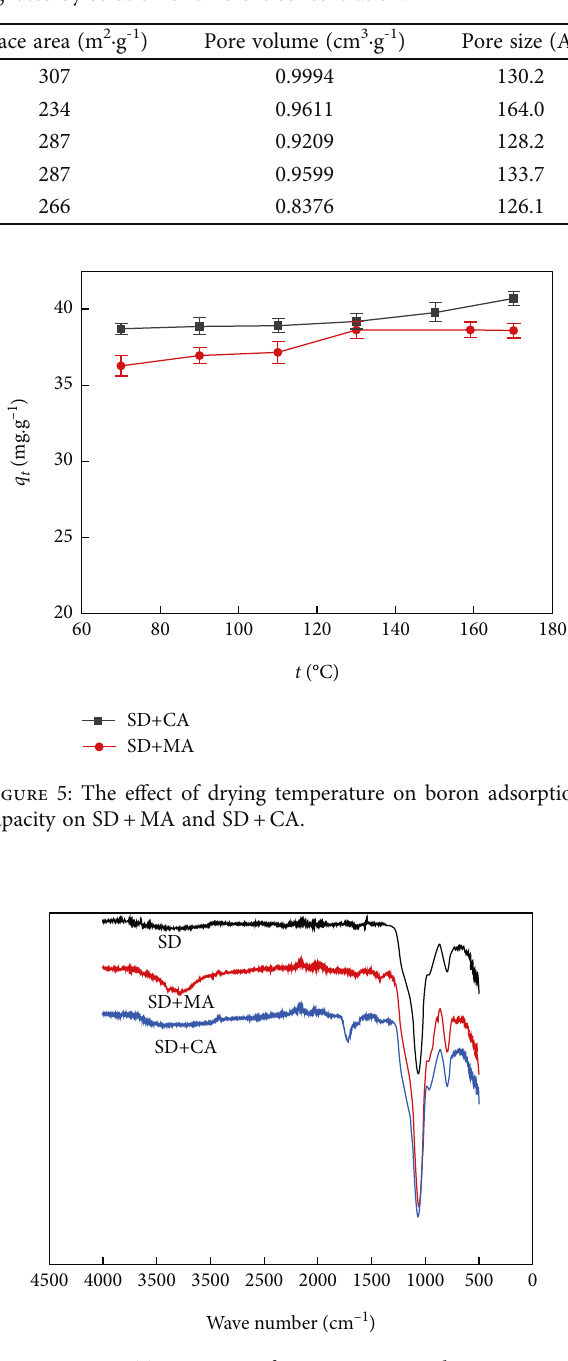
Table 1: The pore size of di ff erent adsorbents impregnated by solution of di ff erent concentration.